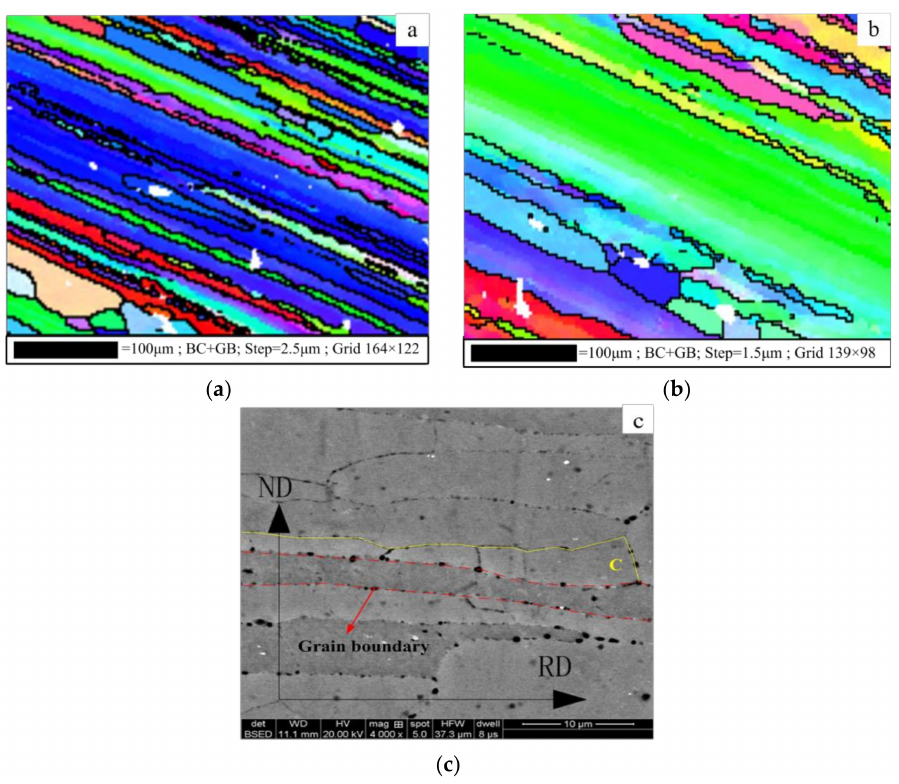
Figure 10. Microstructure of aluminum alloy 7050-T7451 in ND: ( a ) electron backscattered diffraction (EBSD) 500 × ; ( b ) EBSD 1000 × ; ( c ) SEM 4000 × . BC: band contrast; GB: grain boundary.